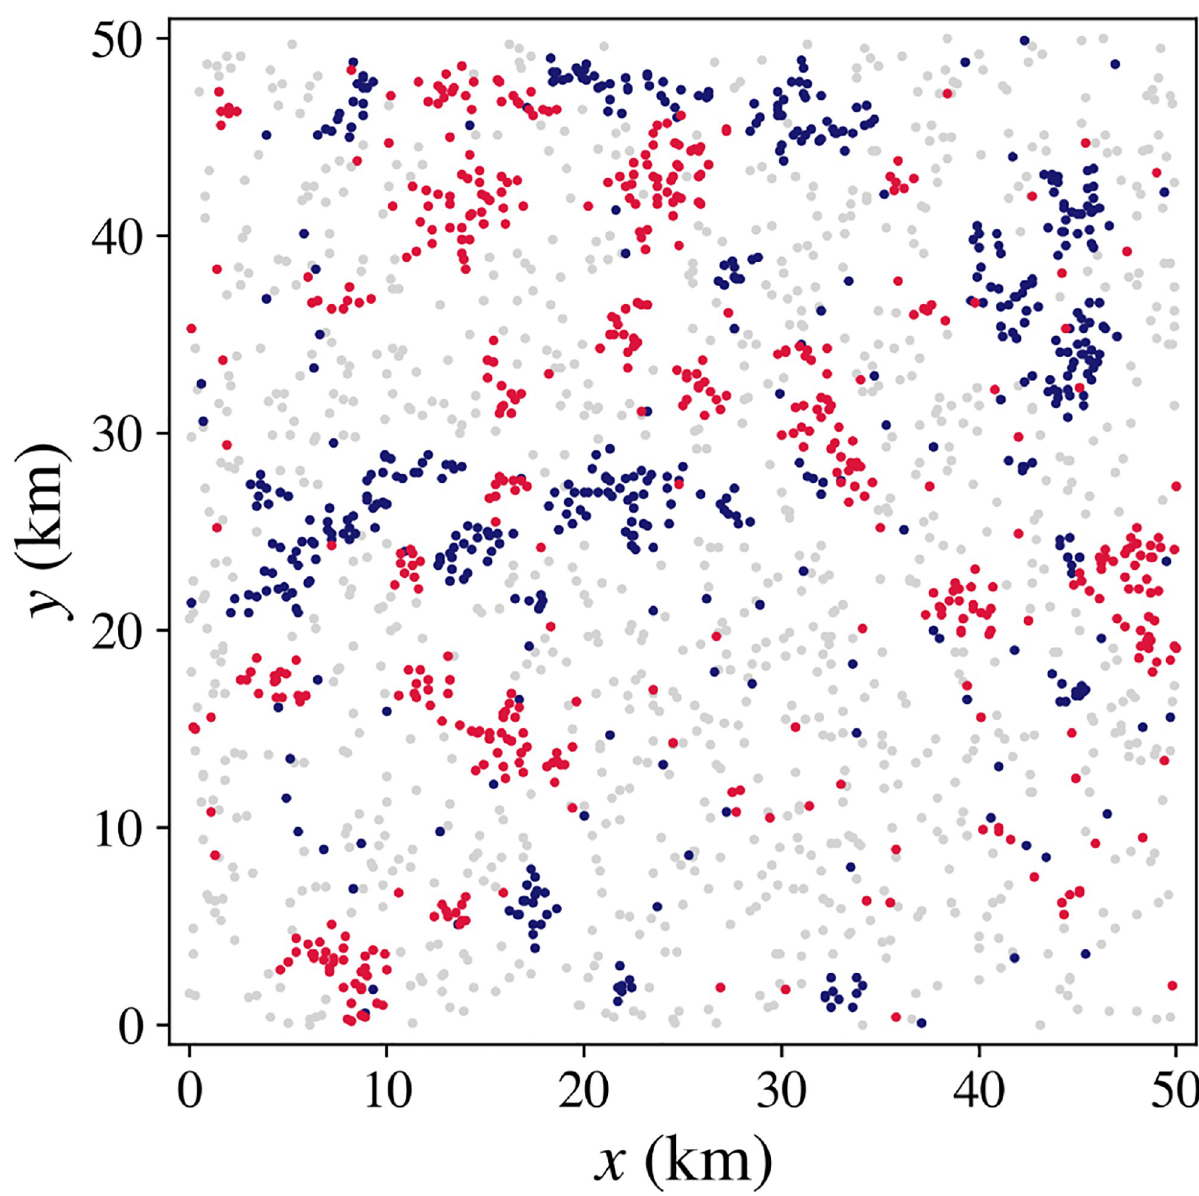
Fig 13. Segregation after 25 years of equal numbers of households with q 1 = ± 1 with neighborhood size h = 1 km, system size R = 50 km, and U 0 =